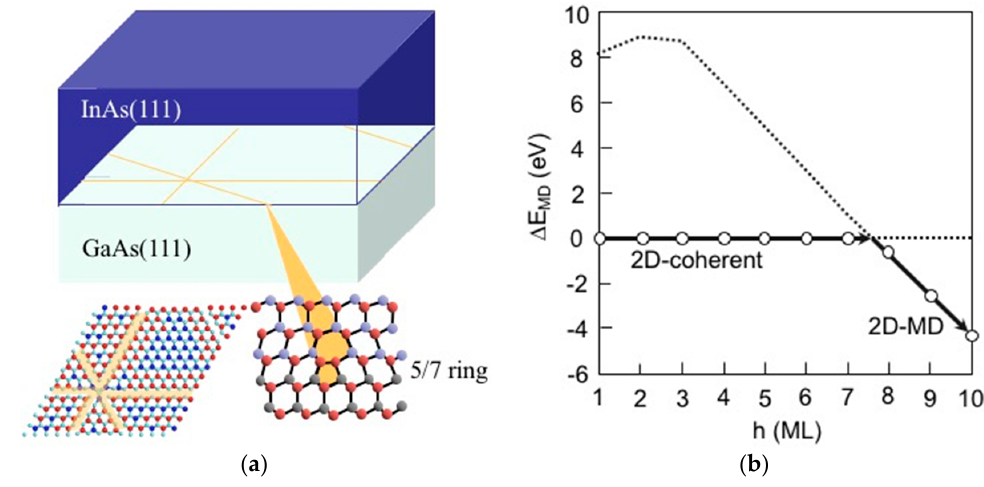
Figure 4. ( a ) Schematic of the 2D growth with dislocation (5/7-ring core structure) network formation at the interface; ( b ) Calculated energy difference between the 2D coherent growth (2D-coherent) and the growth with MD (2D-MD) as a function of layer thickness h.